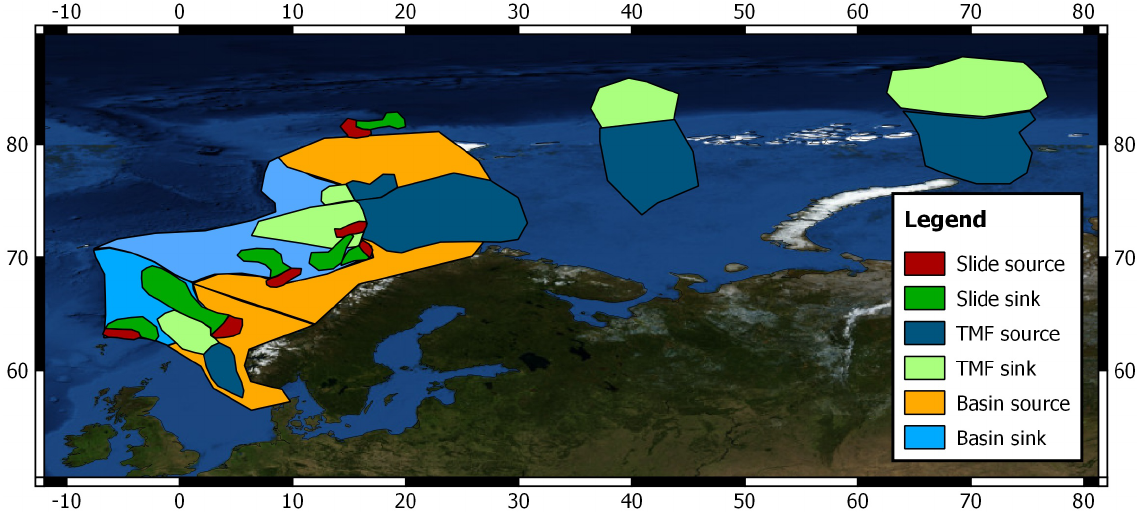
Figure B1. Shape of erosion events, derived from Taylor et al. (2002) and Winkelmann et al. (2008).